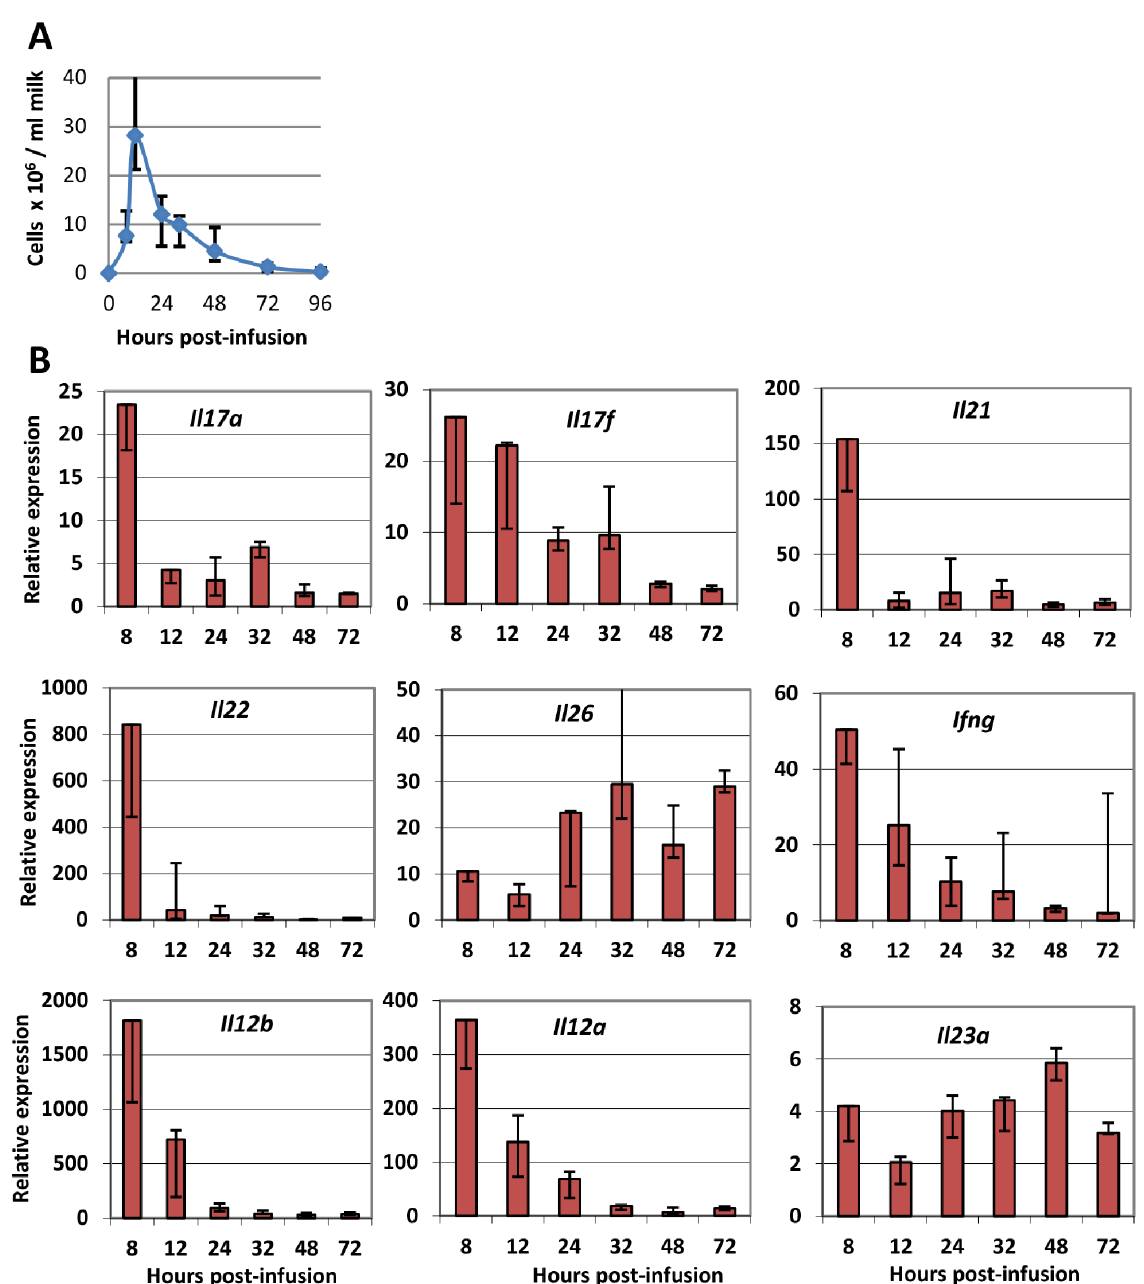
Figure 6. Characterization of cytokine expression in milk cells following intramammary challenge with ovalbumin. Five responder cows were challenged in one quarter with 25 m g ovalbumin and milk cells were collected for RT-qPCR. A) Kinetics of cellular influx in milk of challenged quarters. B) Kinetics of the relative mRNA expression of the indicated cytokines or cytokine components. Median values (Q1, Q3) are shown. It is important to keep in mind that relative expressions, contrary to absolute expression, do not allow comparisons between genes.